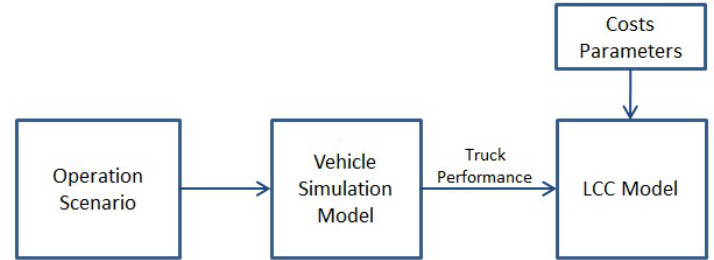
Figure 1. Overview of the holistic model including the vehicle simulation model and the life cycle costs (LCC) model.